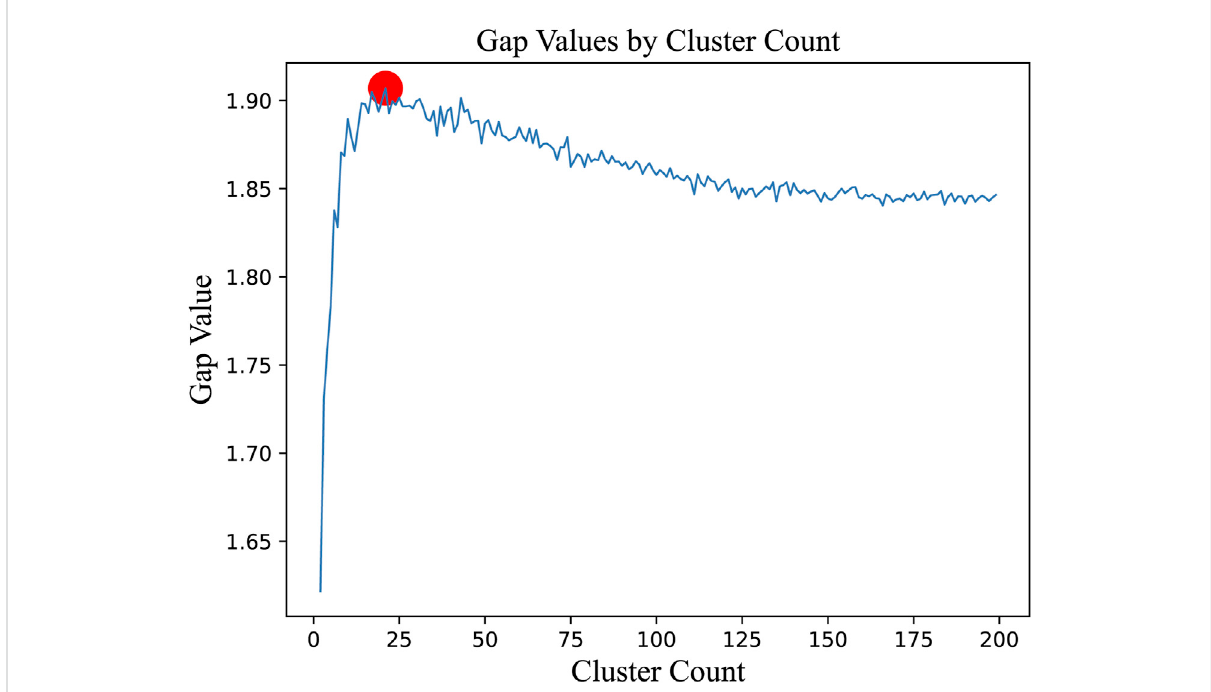
FIGURE 8 Variation curve of the gap value with respect to the cluster count. The red dot is the optimal number of clusters.